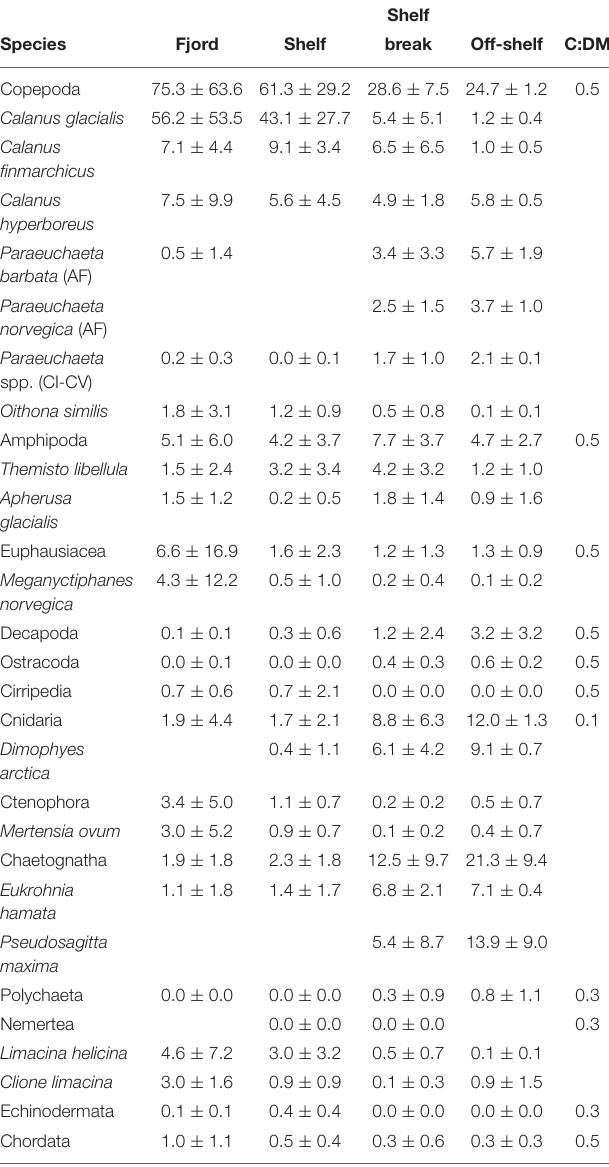
TABLE 3 | Mean zooplankton biomass (mg dry mass m − 3 ) and standard deviation of major taxonomical groups and 18 taxa with most biomass across the four areas of the